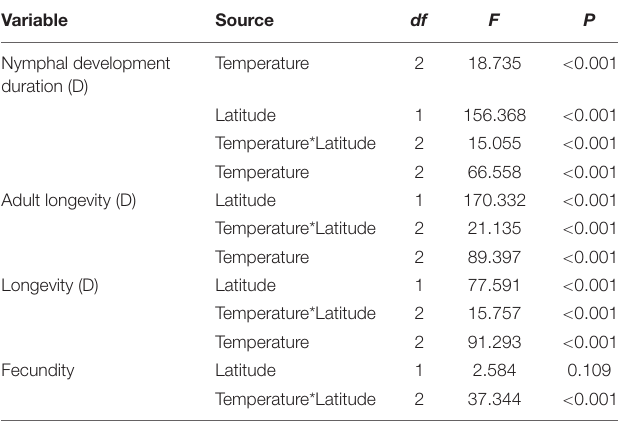
TABLE 1 | The effects of temperature and latitude on the nymphal development duration, adult longevity, longevity and fecundity of S. miscanthi (ANCOVA analysis with temperature as the main factor and latitude as the covariate).